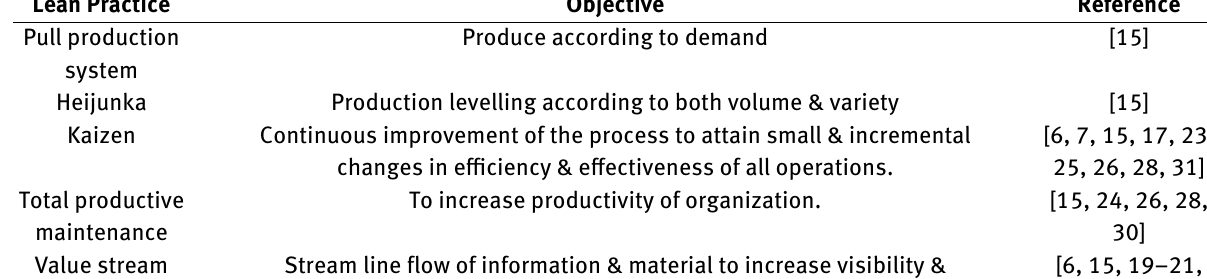
Table 1: Lean tools & their objectives Lean